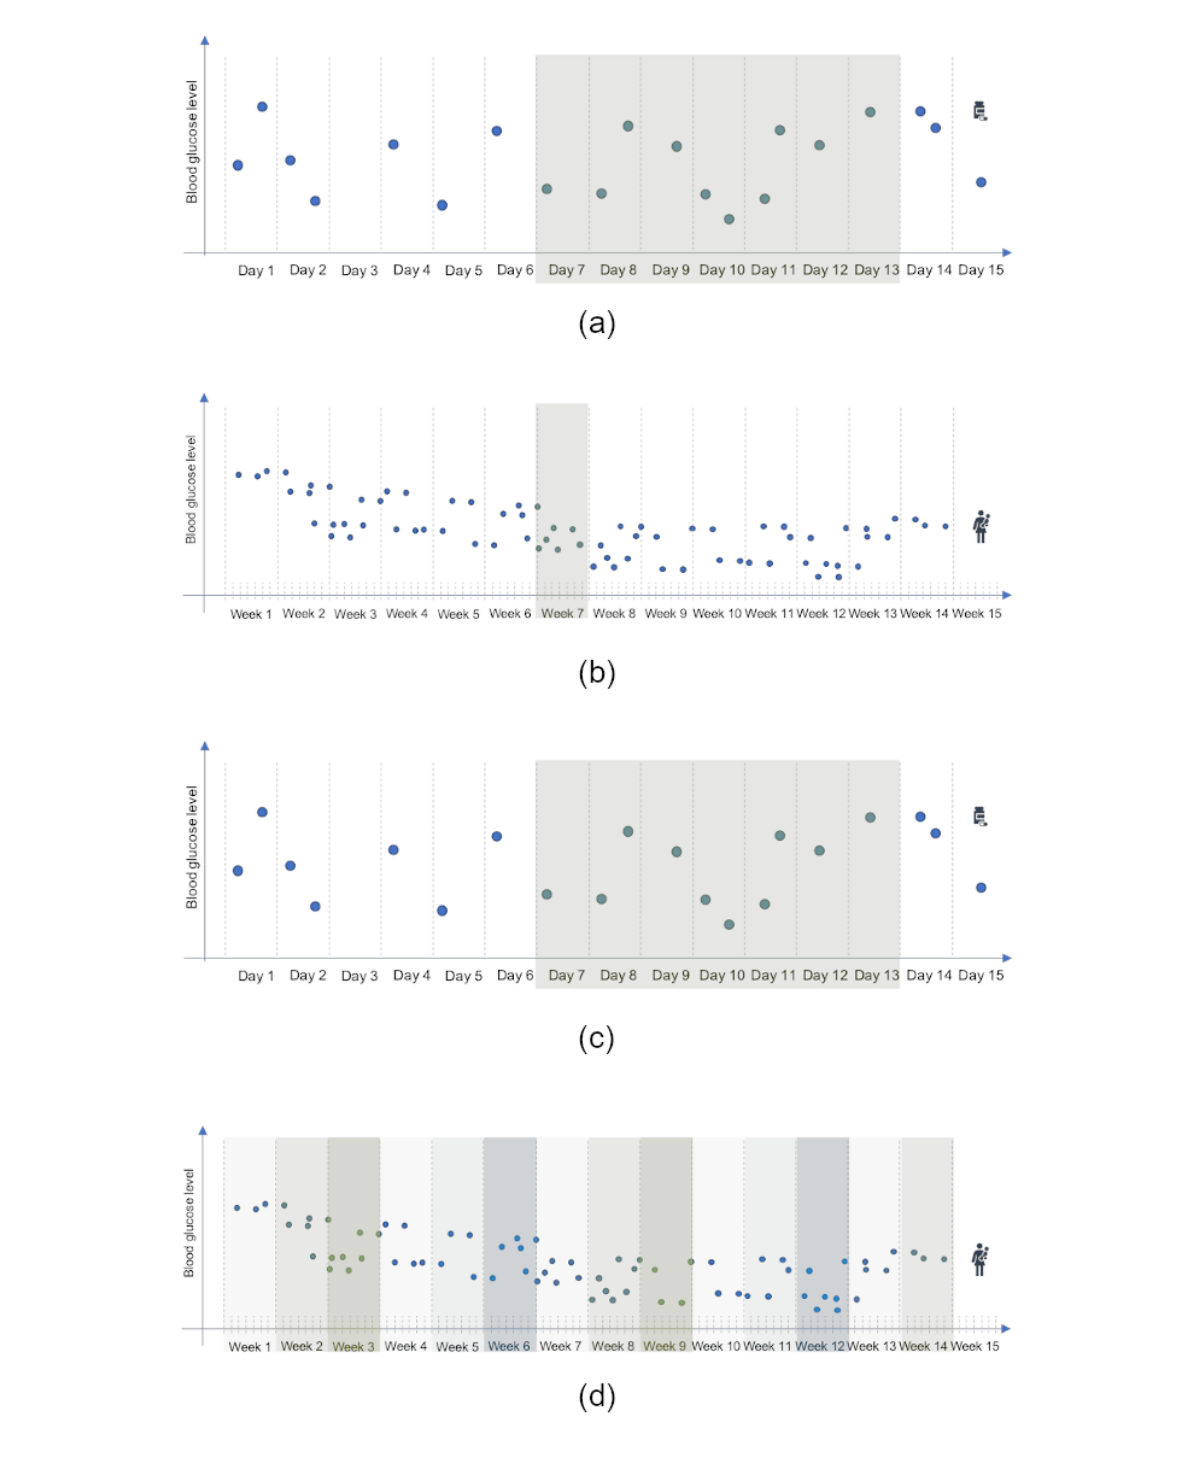
Figure 4. For both (a and b) training and (c and d) validation, summary features are computed on 1 week’s data and a label is assigned according to the group the data belong to (diet–drug and diet–diet). During training, (a) for women with a medication prescription (diet–drug), the week before the first medication dosage is considered for training. A 1-day gap between the training week and the medication event is maintained. (b) For women with no medication prescription (diet–diet), a random week is selected among all those available. During validation, (c) for women in the diet–drug group, we used a similar approach to training and computed the features on the week before the first day of medication (leaving a 1-day gap before the medication event). (d) For women in the diet–diet group, instead, we considered each week available for testing as an independent sample on which to perform a